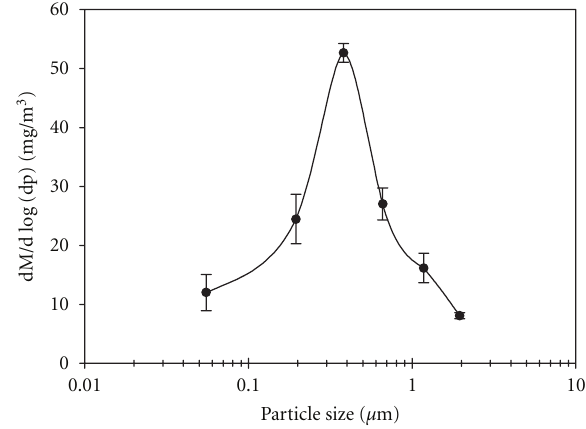
Figure 3: Size distribution of test